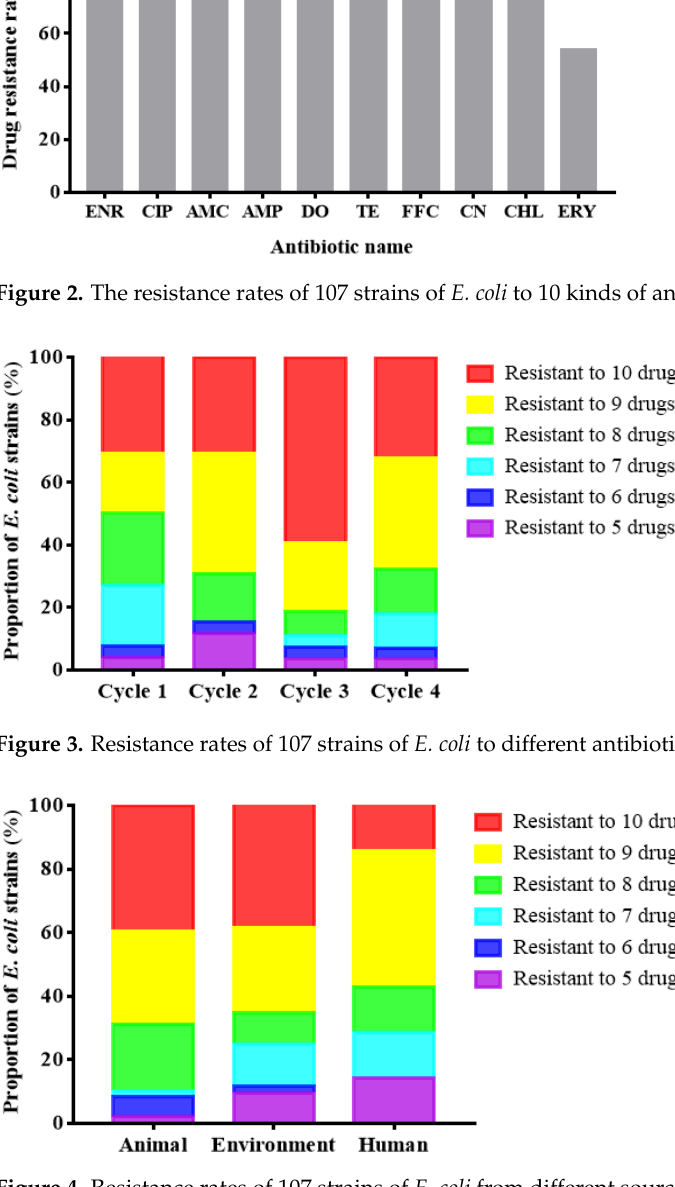
This study found that the E. coli isolated from the broiler farm had a significant positive correlation to ENR and CIP resistance (Table 4). Even the farm has never used CIP as a medicine for clinical prevention and treatment of chicken diseases in each breeding cycle. However, the resistance rate of 107 E. coli strains isolated from the site to CIP was as high as 80.37%. The resistance of E. coli to CIP may increase with the increase of its resistance to ENR. Similar results include DO and TE, both of which belong to the tetracycline class, and FFC and CHL, which belong to the same class of chloramphenicol (Table 4). The difference was that ERY, which belongs to macrolides, and CN, which belongs to aminoglycosides, showed a strong positive correlation with drug resistance (Table 4). It should be noted that this result can only represent the correlation between the ten antibiotics tested, and there may also be a stronger correlation between an untested antibiotic and a certain drug tested in this study.